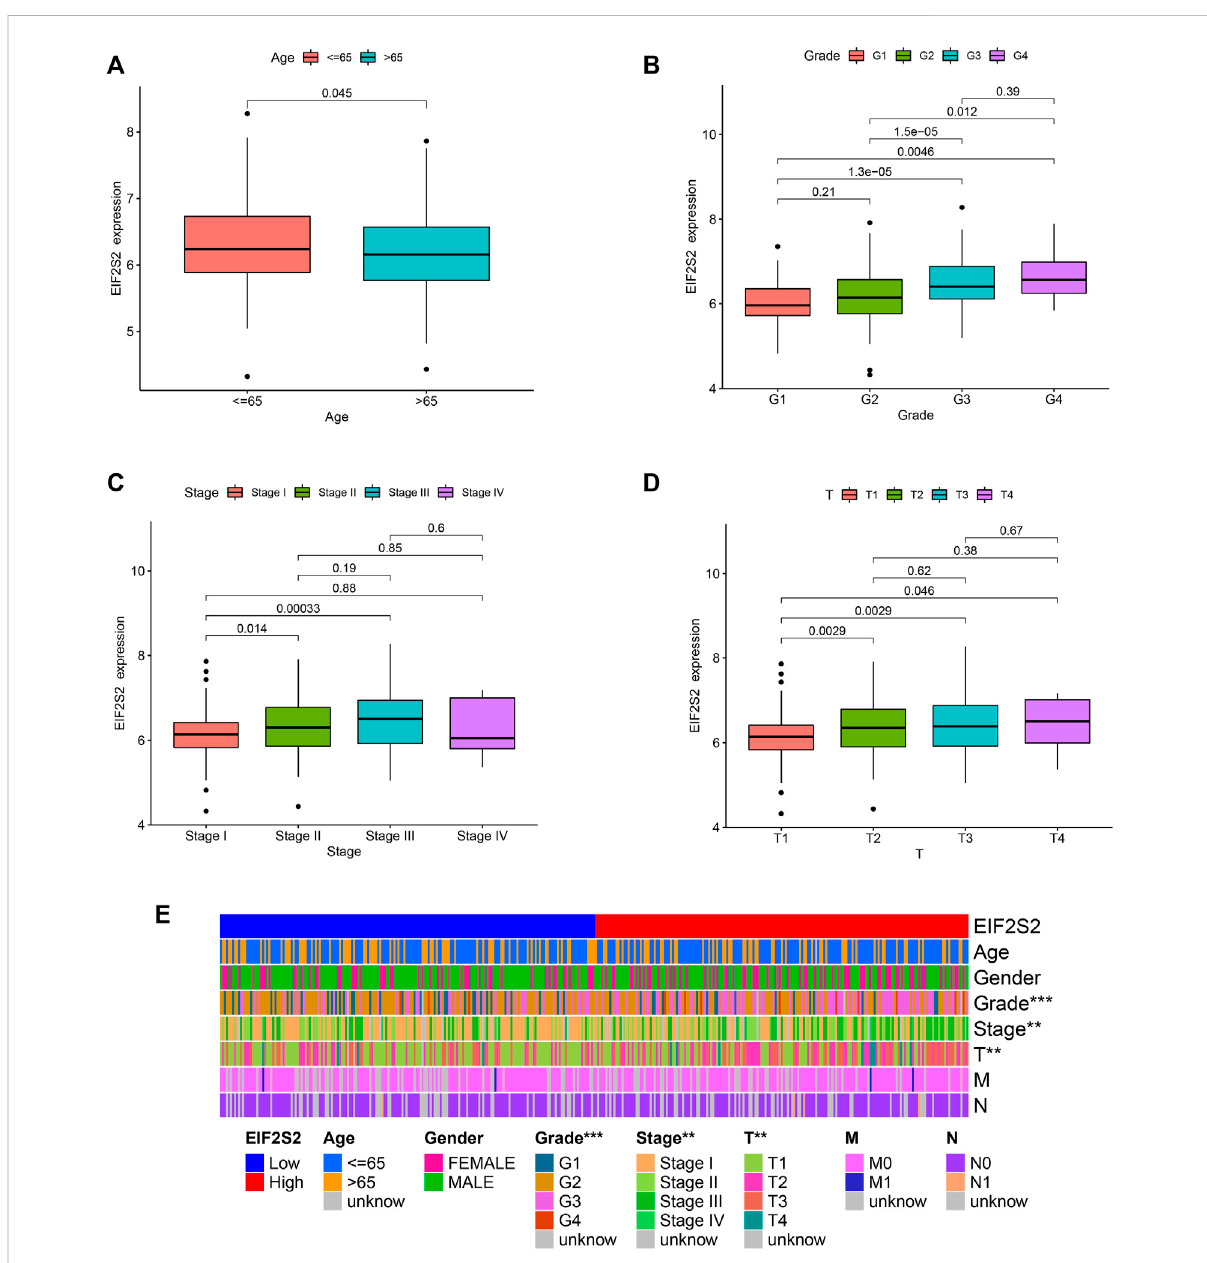
FIGURE 3 Association between the EIF2S2 expression and different clinicopathologic characteristics. (A) Association between the EIF2S2 expression and theageofHCC. (B) Association between theEIF2S2expressionandthehistologic grade ofHCC. (C) Association between theEIF2S2expression and the pathologic stage of HCC. (D) Association between the EIF2S2 expression and the T stage of HCC. (E) Heatmap of the relationship between EIF2S2 expression and clinicopathological analysis. * p < 0.05, ** p < 0.01, *** p <